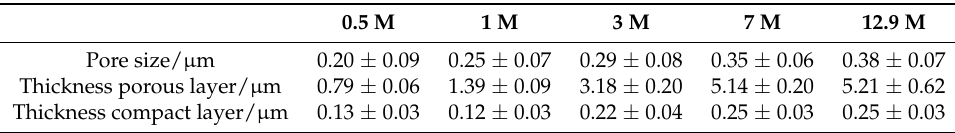
Table 1. Pore size, thickness of the porous layer and thickness of the compact layer derived from SEM